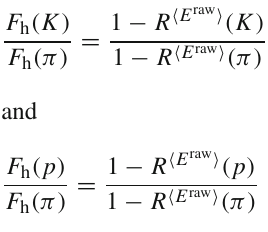
than the π ± one in the CMS result [15]. In the same